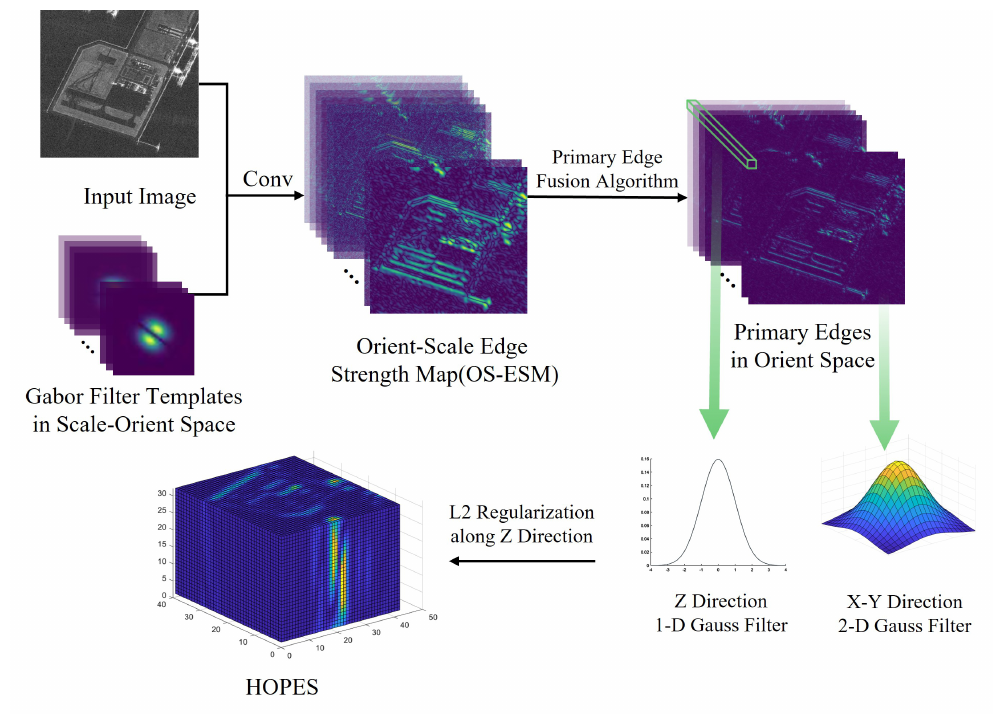
Figure 5. Main flow of constructing HOPES 3D density